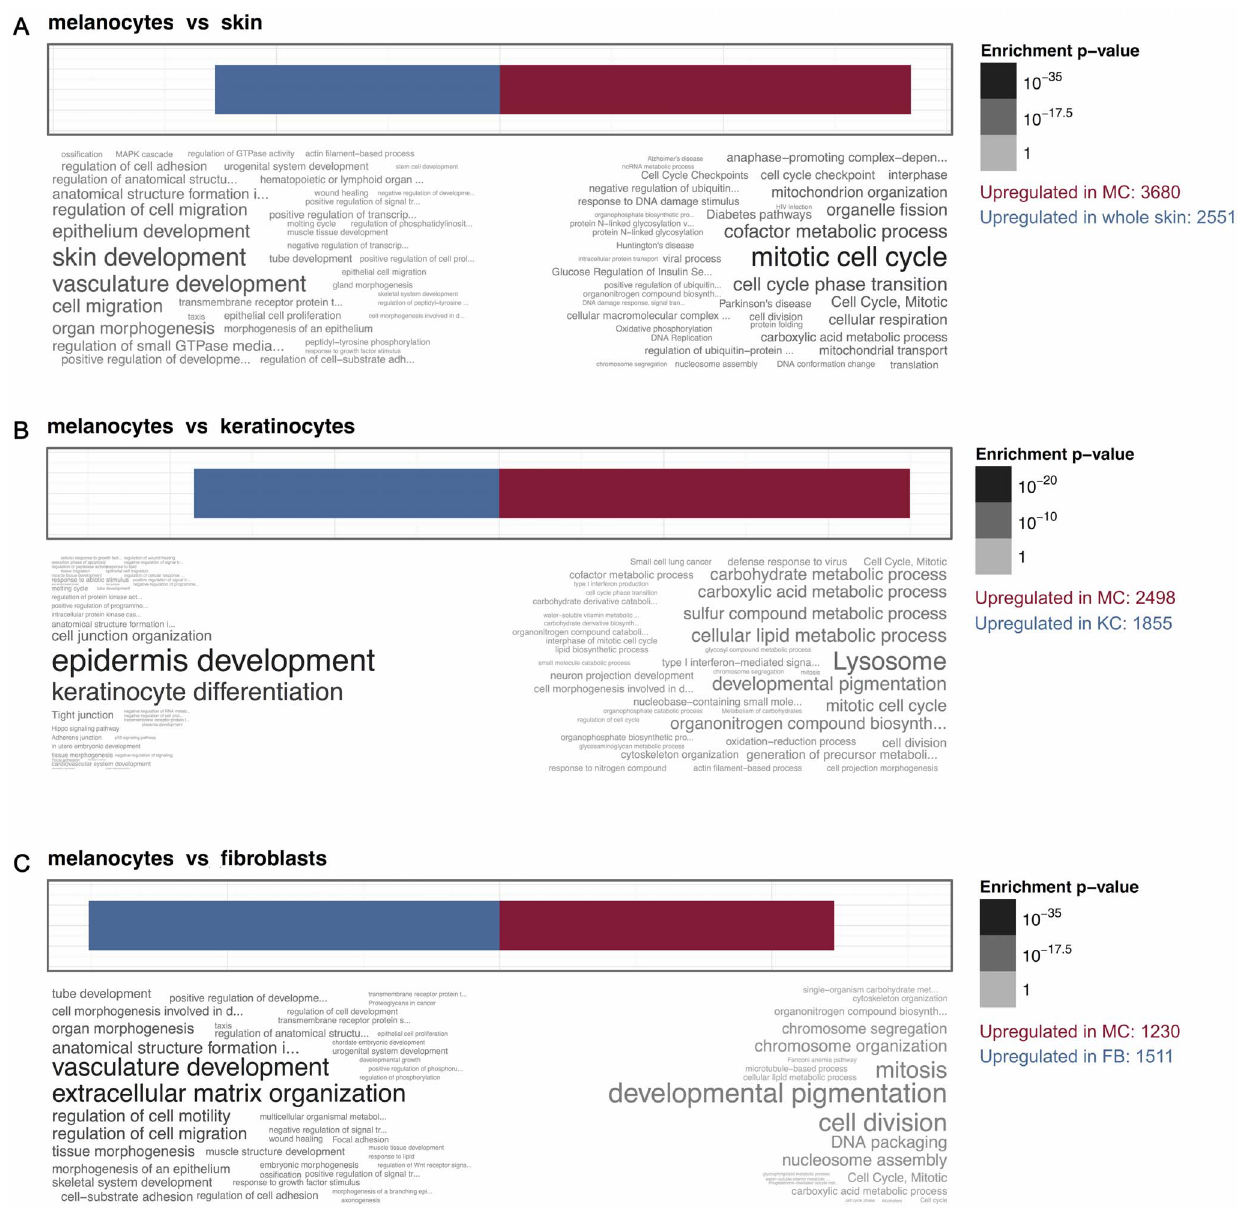
Fig. 2. Comparative pathway analysis of MC and KC, FB and whole skin. Red plots indicate pathways, which were prominently expressed in MC. Blue plots mark pathways, which were downregulated in MC (A, B, C) and concomitantly upregulated in the whole skin (A), KC (B) and FB (C), respectively. The word sizes in wordclouds are defined by the